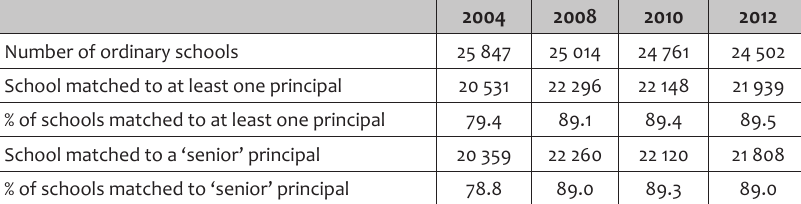
Table 1: Matching Persal and